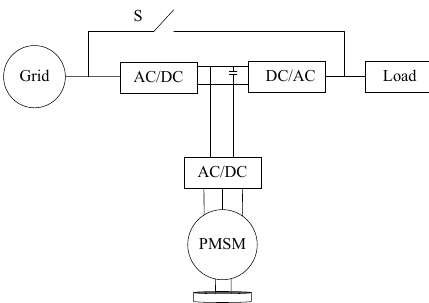
Fig. 9. The Online Double Conversion Type UPS of FESS.